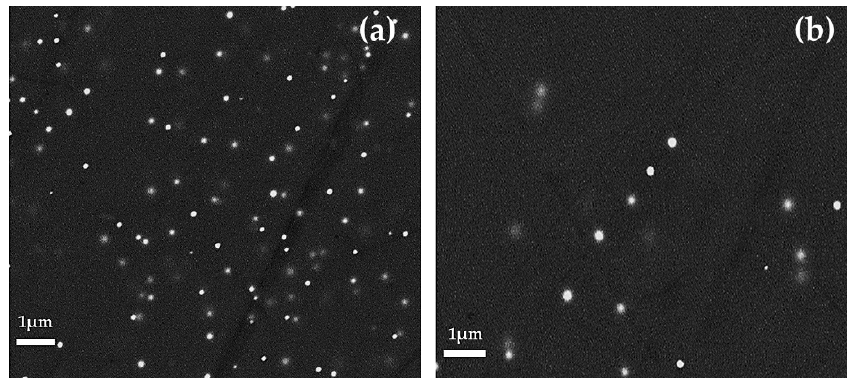
Figure 13. FEG–SEM micrographs of Gr-1 samples. Di ff erent red layer with di ff erent number and size Figure 13 . FEG–SEM micrographs of Gr-1 samples. Different red layer with different number and size of particles in sample R31: ( a ) Orange layer and ( b ) red of particles in sample R31: ( a ) Orange layer and ( b ) red layer.